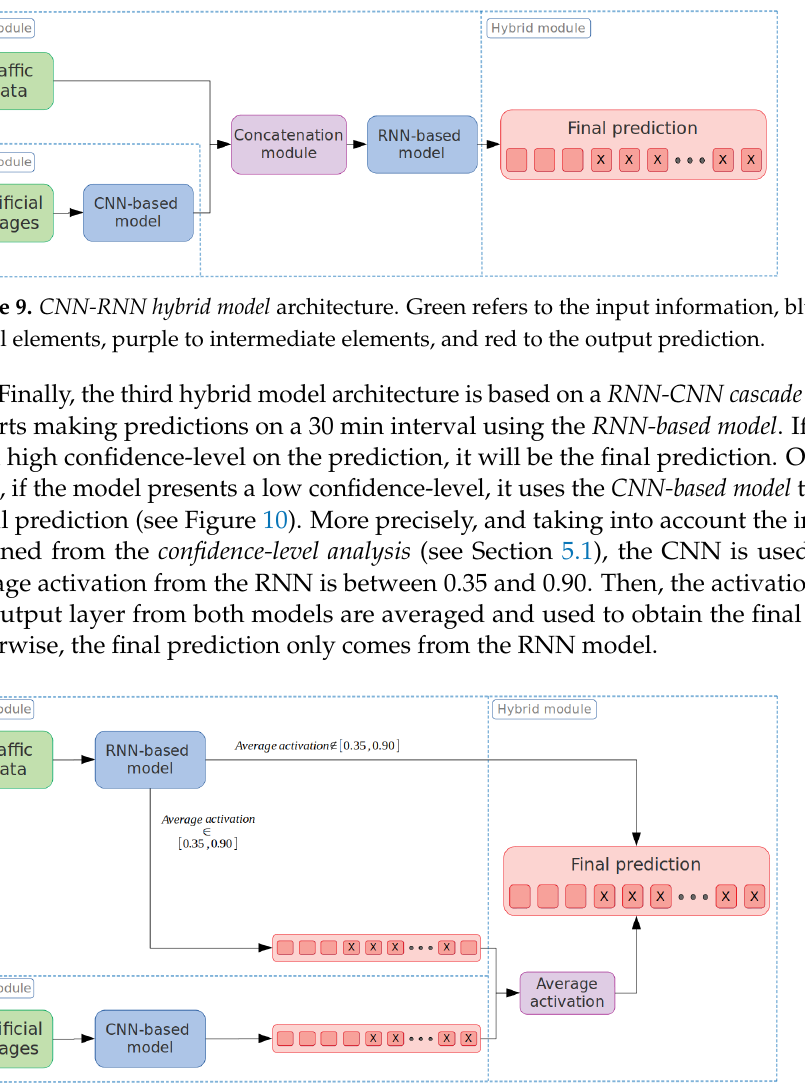
Figure 10. RNN-CNN cascade hybrid model architecture. Green refers to the input information, blue to the DL model elements, purple to the intermediate elements, and red to the output